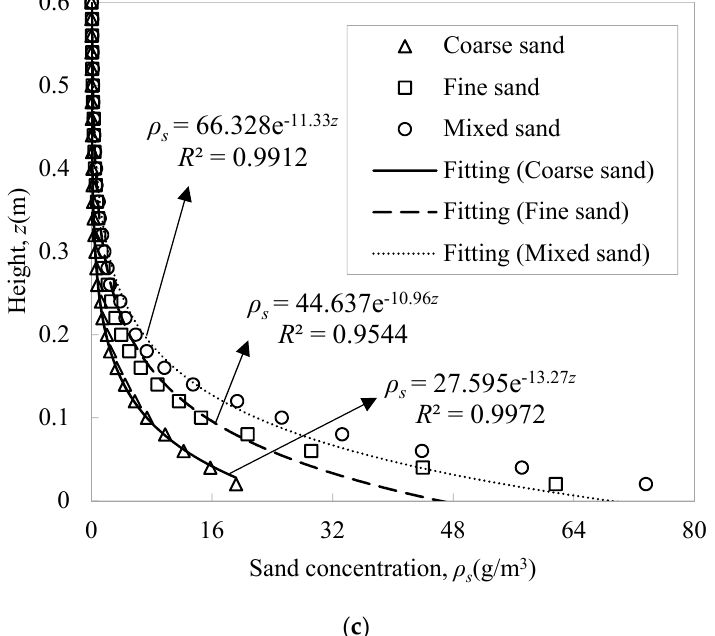
Figure 9. The sand concentration: ( a ) At the indicated wind speed of 14.74 m/s; ( b ) At the indicated wind speed of 16.68 m/s; ( c ) At the indicated wind speed of 18.61 m/s. Table 2. The regression coefficients of the sand transport rate and sand The least-square method is used to fit the sand concentration at different heights.